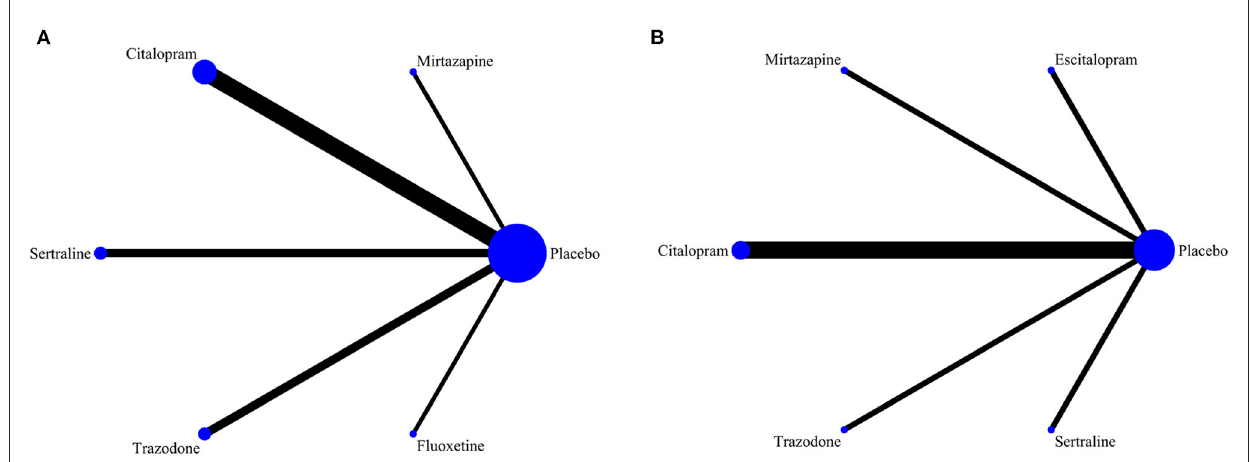
FIGURE2 (A) Network diagram of the efficacy of different drug therapies for agitation symptoms in patients with dementia. (B) Network diagram of the safety of different drug therapies for agitation symptoms in patients with